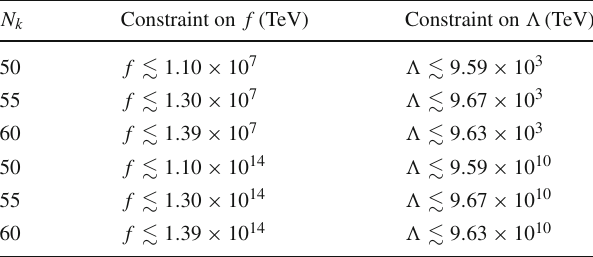
Table 12 Results for the constraints on the mass scales f and (cid:5) for Exponential SUSY inflation in the high-energy limit of Randall– Sundrum brane model using the last data of PLANCK. The top table shows the results using M 5 = 10 5 TeV while the bottom table